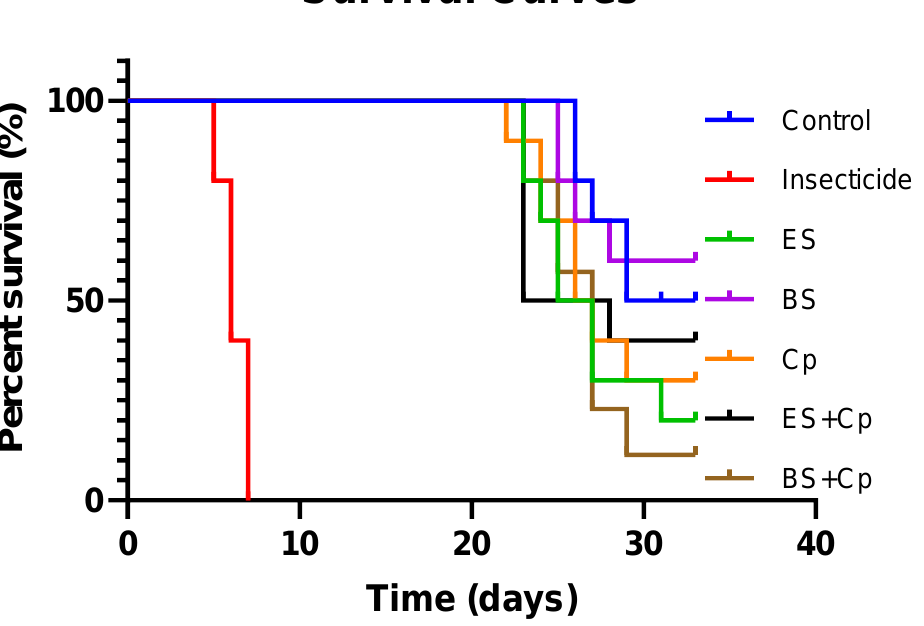
Figure 5. Kaplan–Meier survival functions of Brevicoryne brassicae under soil amendment (SAM) treatments of ES (Elemental Sulfur), BS (Bio Sulfur), and Cp (Compost) (Mantel–Cox test, p <